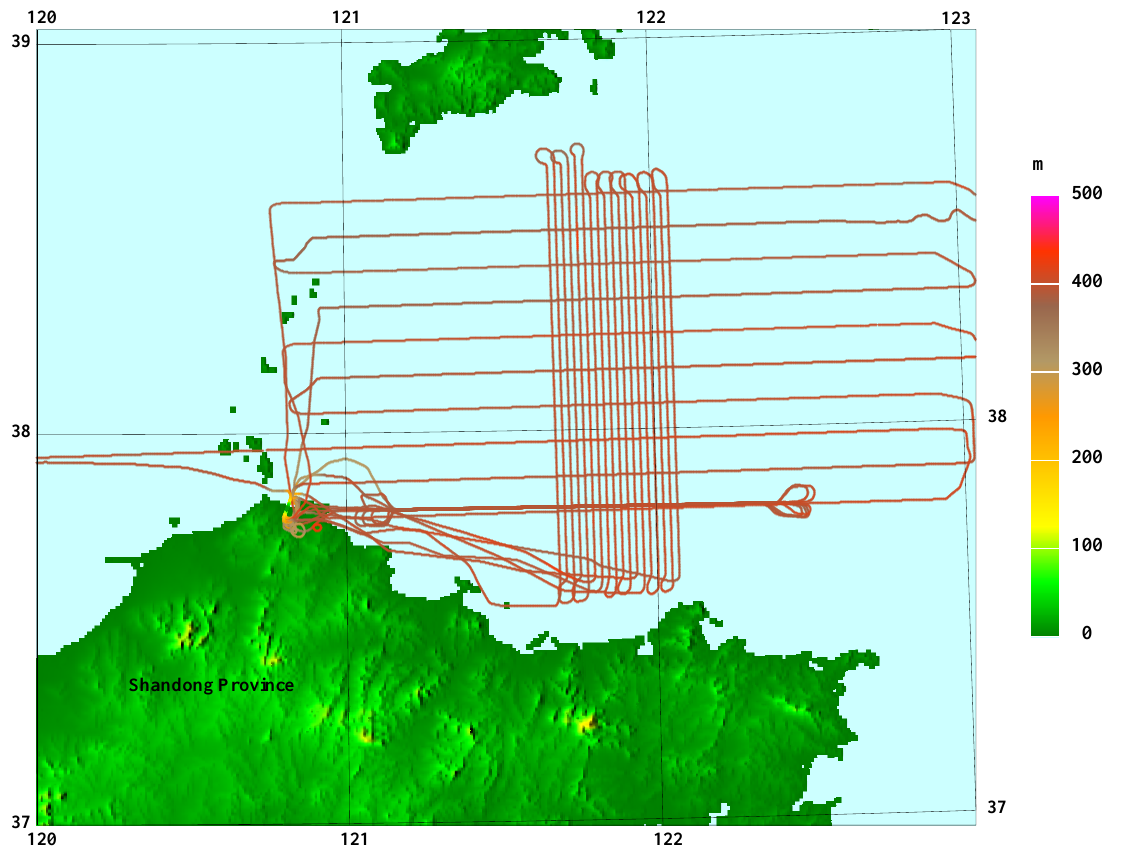
Figure 6. The map of the flight test region carried out in April